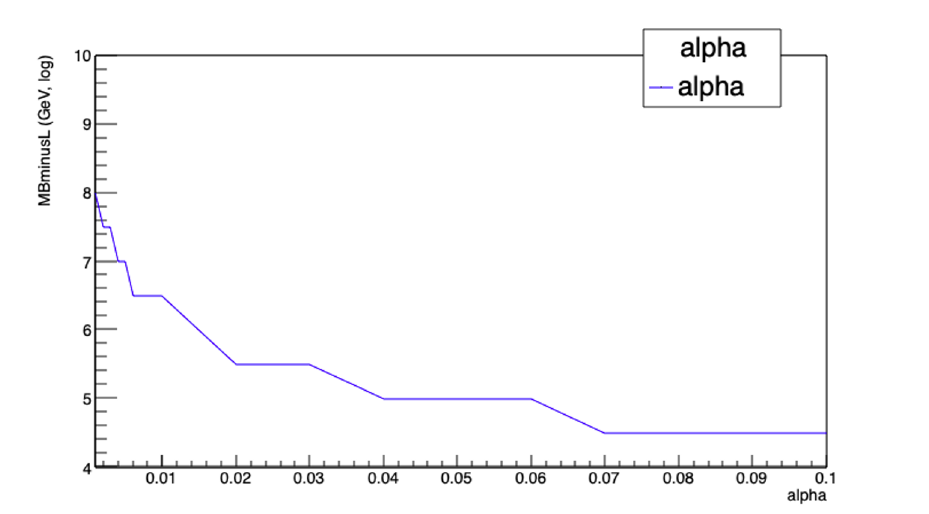
Figure 7 . The lowest value of M B − L consistent with both electron EDM and baryon asymmetry experiments plotted as a function of α